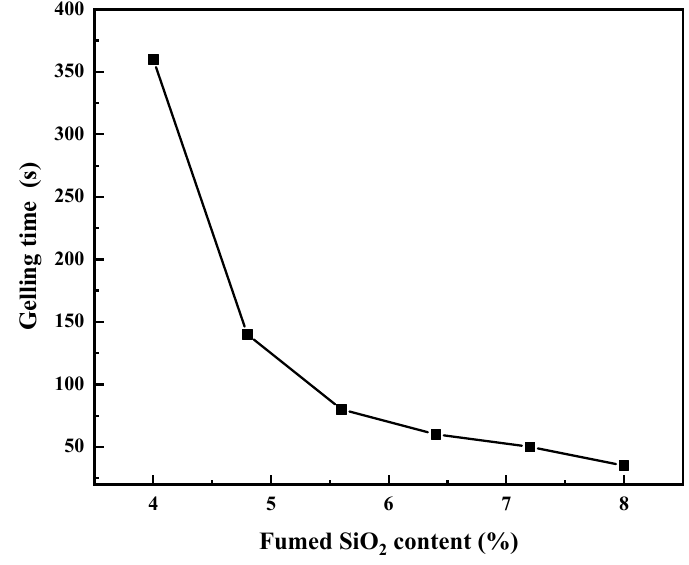
Figure 4. E ff ect of fumed SiO 2 content on the gelling Figure 4. Effect of fumed SiO 2 content on the gelling time.